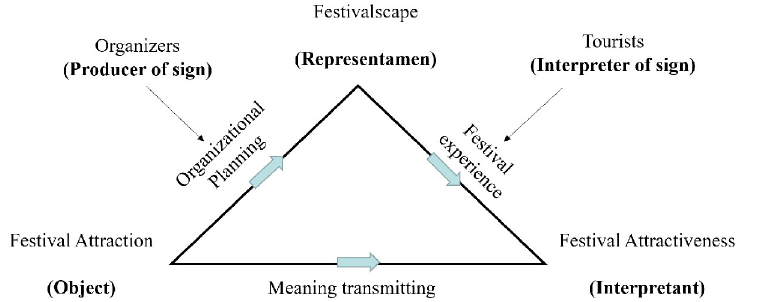
Fig 1. The semiotic analysis framework of festival tourist